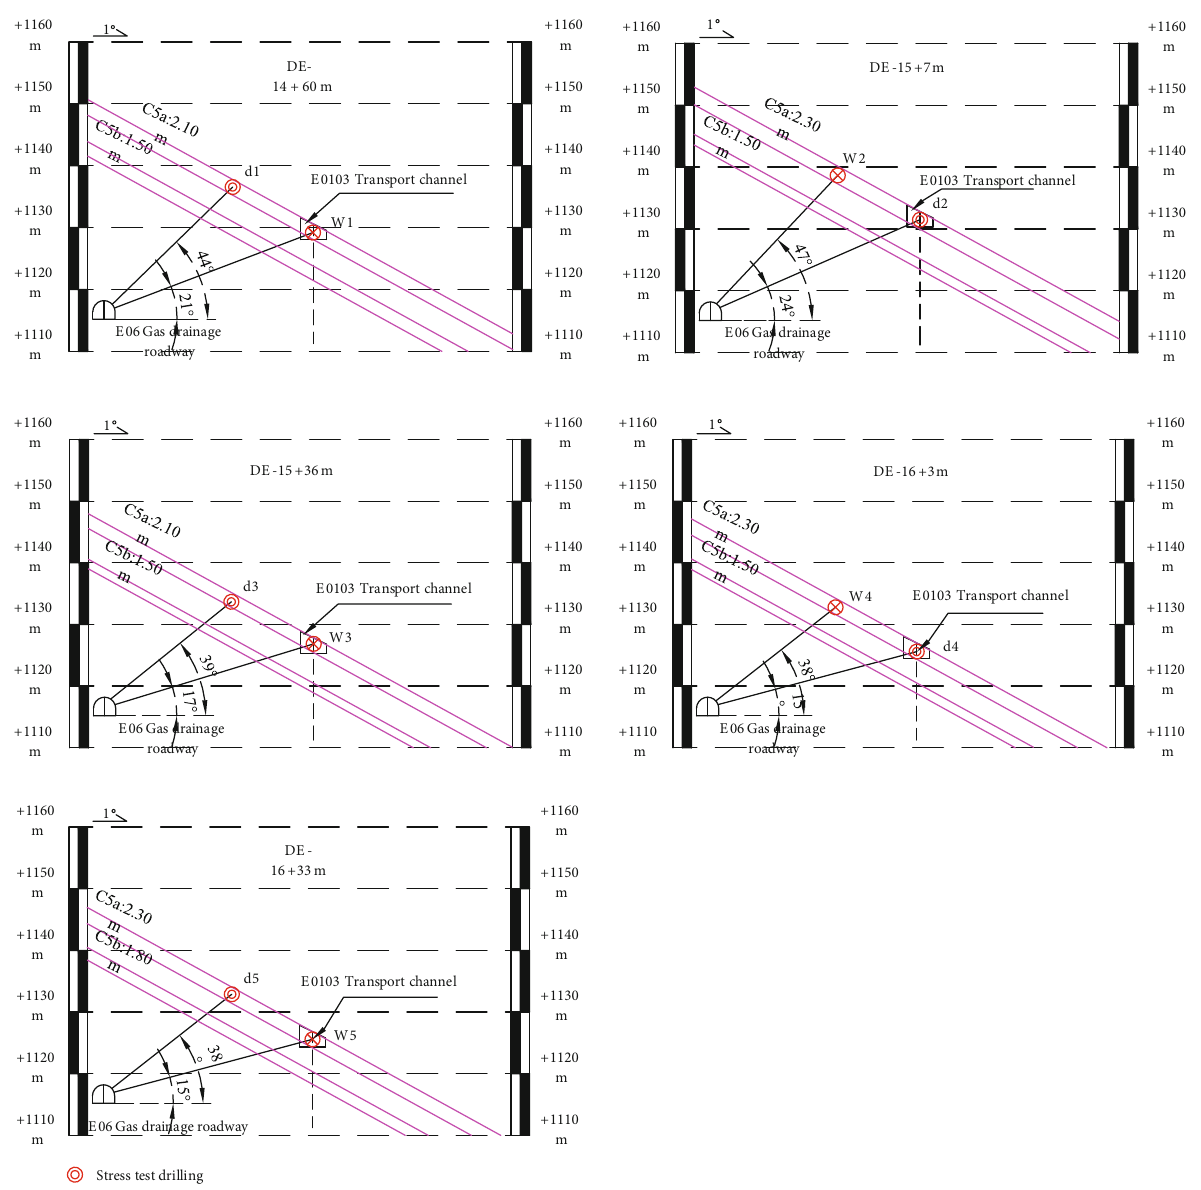
Figure 9: Cross-sectional view: measuring points in the E0103 transport